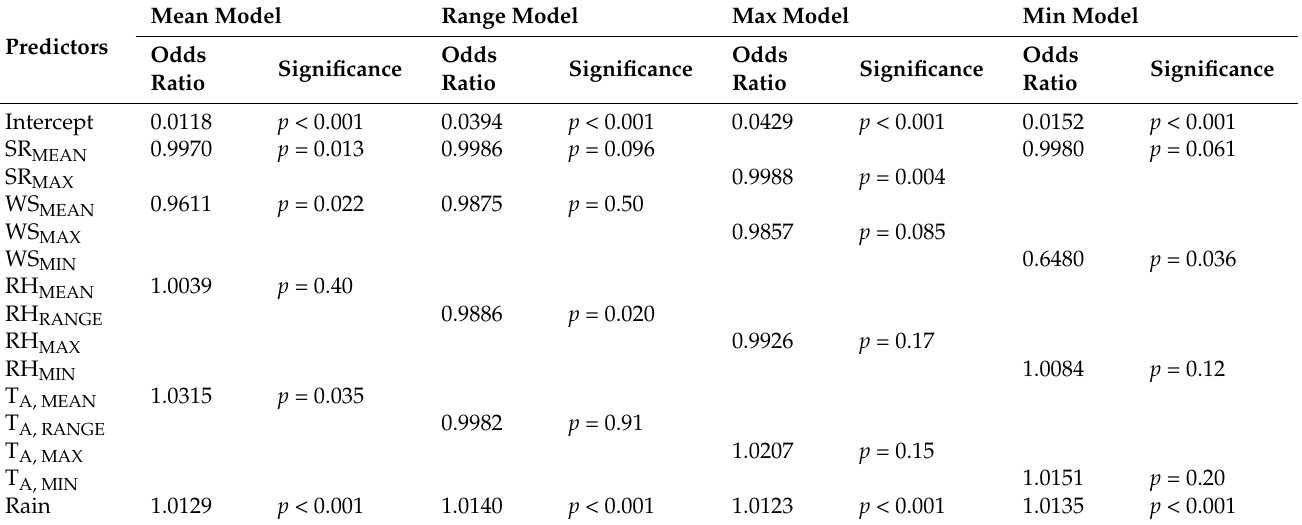
Table 8. The odds ratios for the effect of the mean, range, max, and min for ambient temperature (T A , ◦ C), solar radiation (SR, W/m 2 ), wind speed (WS, m 2 ), relative humidity (RH), and rain (mm) on the incidence of pH